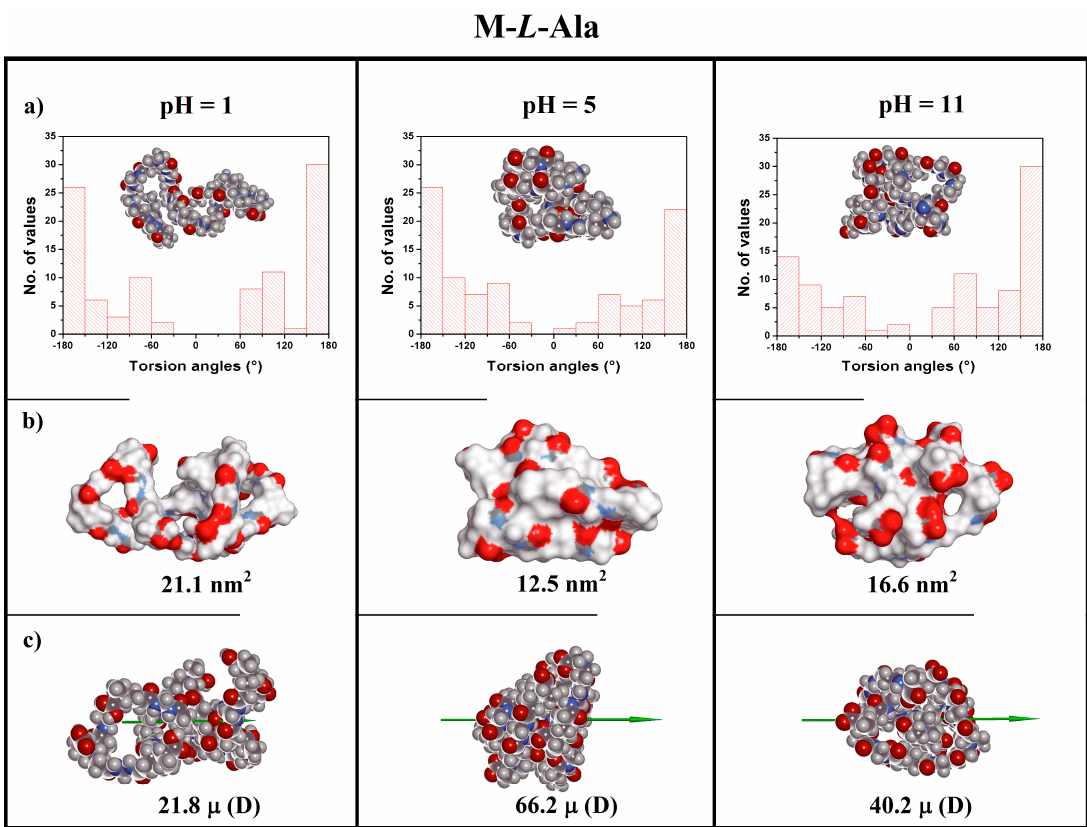
Figure 10. ( a ) Main chain molecular conformations in water at the end of the MD runs for M- L -Ala at pH 1, 5 and 11 and torsion angle distributions around the main chain bonds: the histogram are shown with a binning of 30°. Color codes: C atoms dark grey; H atoms light gray; N atoms blue; O atoms red. ( b ) Solvent accessible surface area in water. The surface area is in dark grey near C atoms, in light gray near H atoms, in blue near N atoms and in red near O atoms. ( c ) Dipole moments in water. Color codes are the same as in row ( a ).